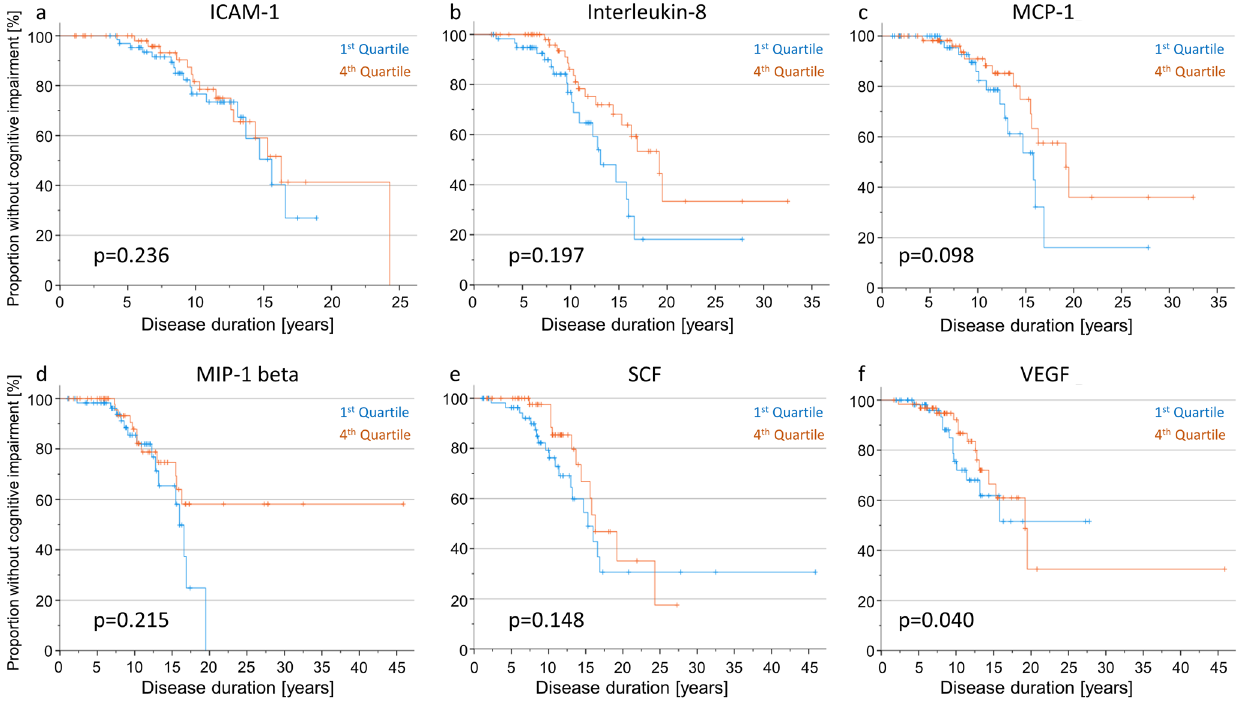
Fig. 1 Kaplan – Meier curves and Cox regression analyses depicting the duration until the development of cognitive impairment in PD GBA_WT people strati fi ed by in fl ammatory pro fi les. a – f Kaplan – Meier analyses of the most relevant in fl ammatory markers (ICAM-1, interleukin-8, MCP-1, MIP-1 beta, SCF and VEGF) revealed interleukin-8 to have a signi fi cant impact on the duration until the development of cognitive impairment. Fifty percent of patients in the highest in fl ammatory quartile of interleukin-8 levels reached this endpoint after 19 years of disease duration compared to 13 years in patients in the lowest in fl ammatory quartile ( p = 0.019). However, adjusting the model for age, sex, and disease duration as additional interacting co-variates, only VEGF showed a signi fi cant effect on the duration until the development of cognitive impairment in Cox regression analyses. Fifty percent of patients with high CSF levels of VEGF at baseline (fourth quartile) reached this clinical endpoint after 19 years compared to 16 years in patients with low levels ( fi rst